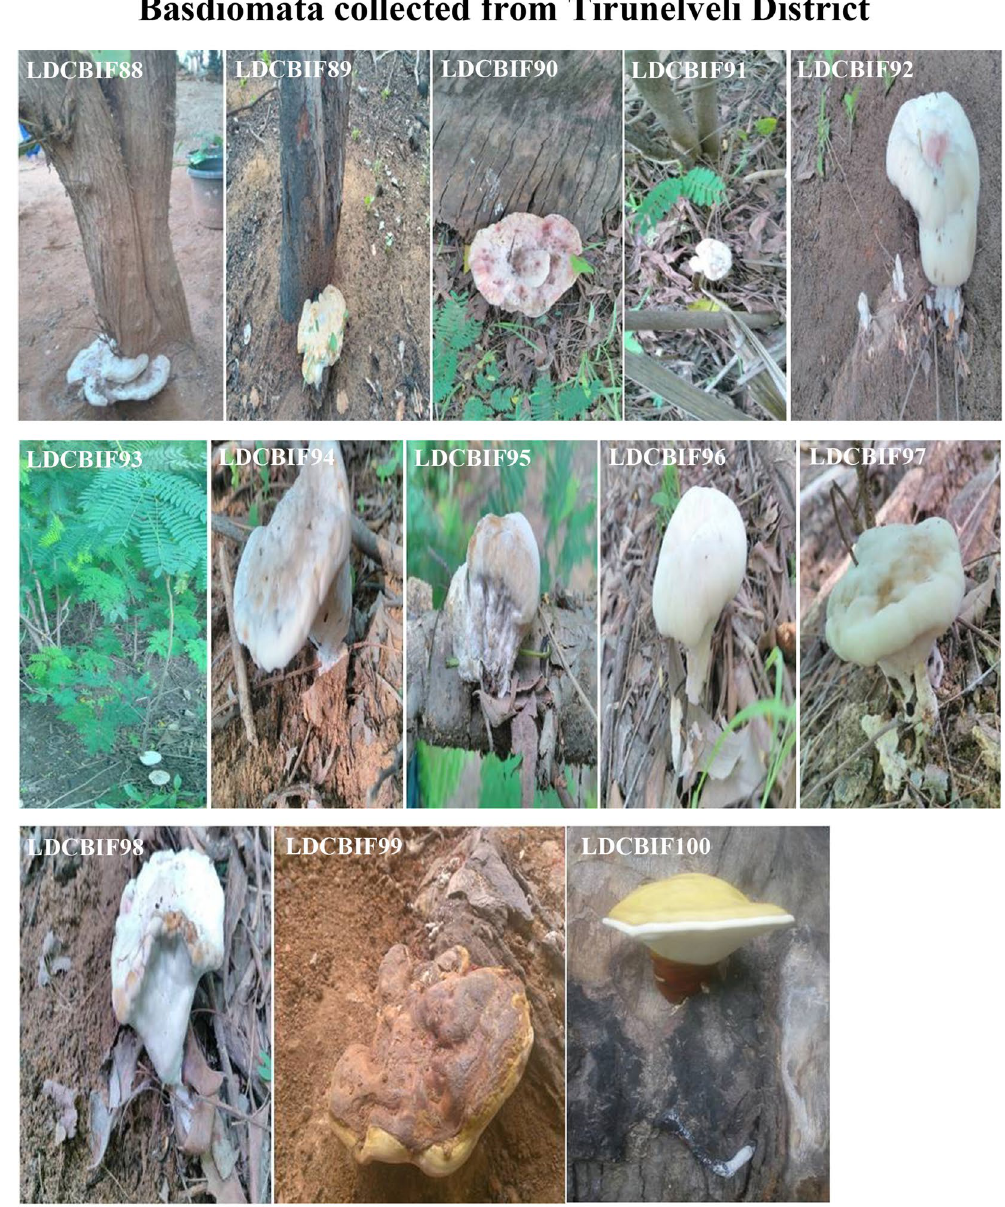
Figure 5. Field photographs of Basidiomata collected from Tirunelveli District. The macrofungi grown on the host species: Nerium sp ., - LDCBIF88; Canthium sp ., -LDCBIF89; Albizzia sp ., - LDCBIF90 - LDCBIF98 and Tamarindus sp., - LDCBIF99 &